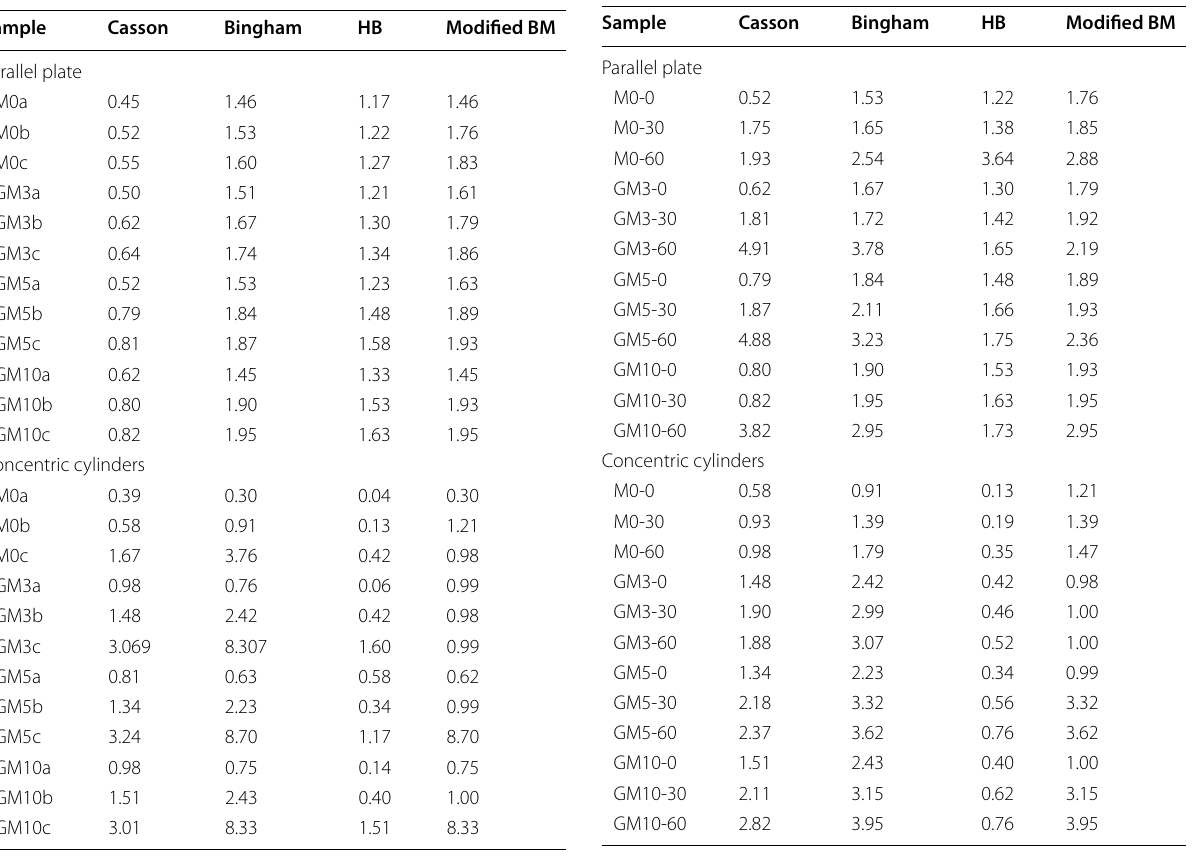
Table 7 Effect of resting time on yield stress